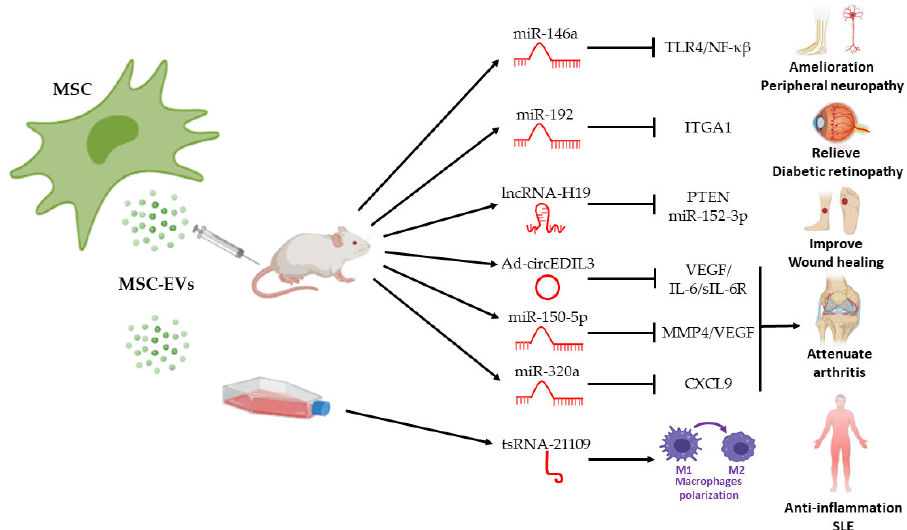
Figure 3. Summary of protective, regenerative or immunomodulatory capabilities of MSC-derived extracellular vesicles (MSC-EVs) administered in experimental models of different ADs. Several studies on non-coding RNA (miRNAs, lncRNA, circRNA and tsRNA) have demonstated their effects and mechanisms as therapeutic systems to ameliorate diabetic peripheral neuropathy, relieve diabetic retinopathy, improve wound healing of diabetic ulcers, attenuate arthritis and exert anti-inflammatory effect in systemic lupus erythematosus (SLE). Arrows indicate activation or induction, T-bars in- dicate inhibition. Circ: circular RNA; CXCL9: Chemokine (C-X-C motif) ligand 9; IL: interleukin; ITGA1: Integrin Subunit Alpha 1; lncRNA: long non-coding RNA; miRNA: microRNA; MMP4: ma- trix metalloproteinase 4; MSC: mesenchymal stem cells; PTEN: Phosphatase and tensin homolog; TRL4: Toll-like receptor 4; tsRNA: transfer RNA-derived fragments; VEGF: vascular endothelial growth factor. Created mainly in biorender.com